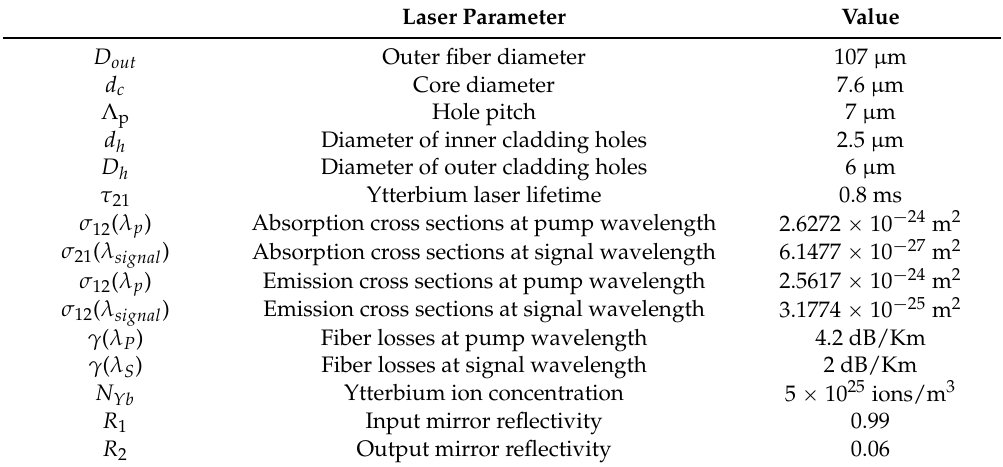
Table 3. Section C